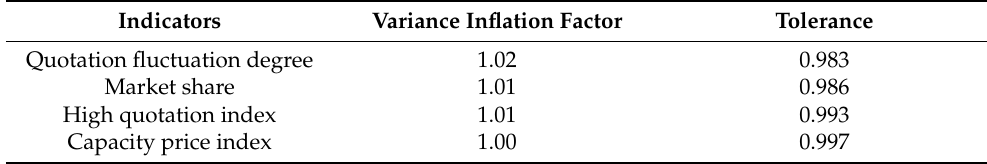
Table 4. Indicator selection results and collinearity test.